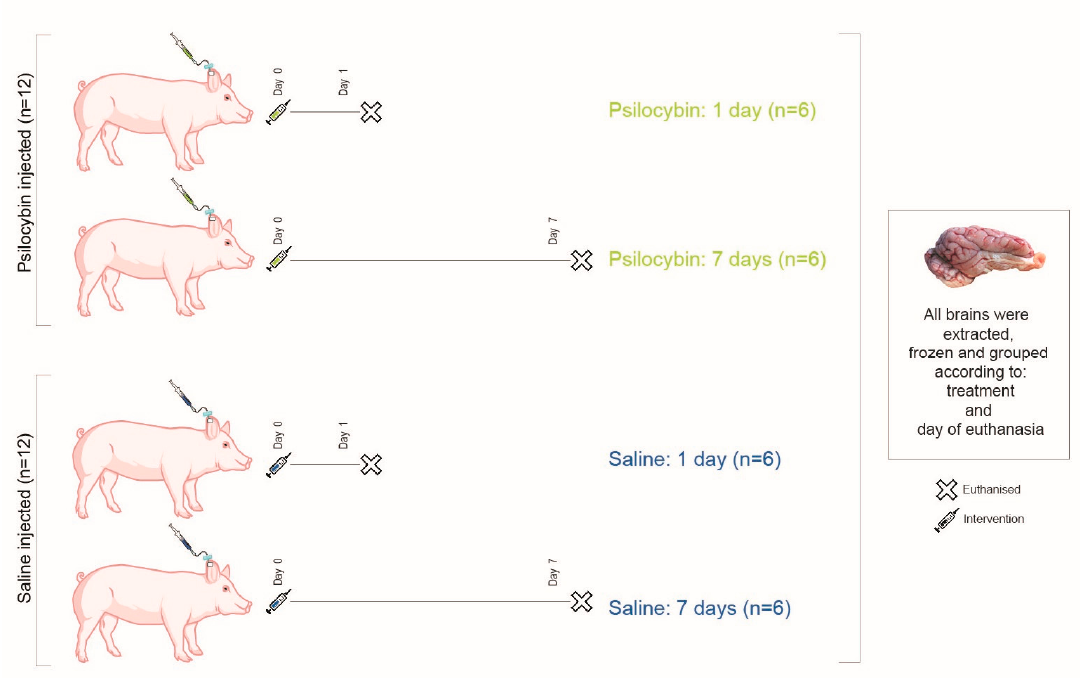
Figure 3. Study design. Twenty-four pigs received an intravenous dose of either 0.08 mg/kg psilocybin or saline. Six pigs from each type of intervention were euthanized one day or seven days post-injection. The pigs were divided into four groups, as depicted in the